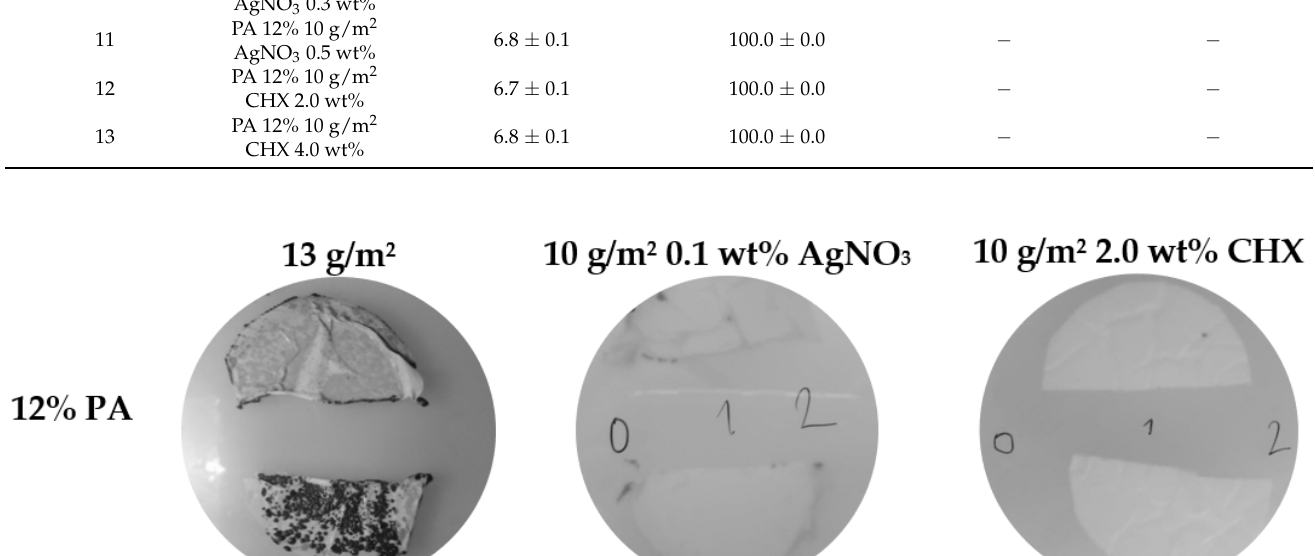
Figure 5. SEM figures of PAs after the filtration of S. aureus CCM 4516 (magnification of 5000×).